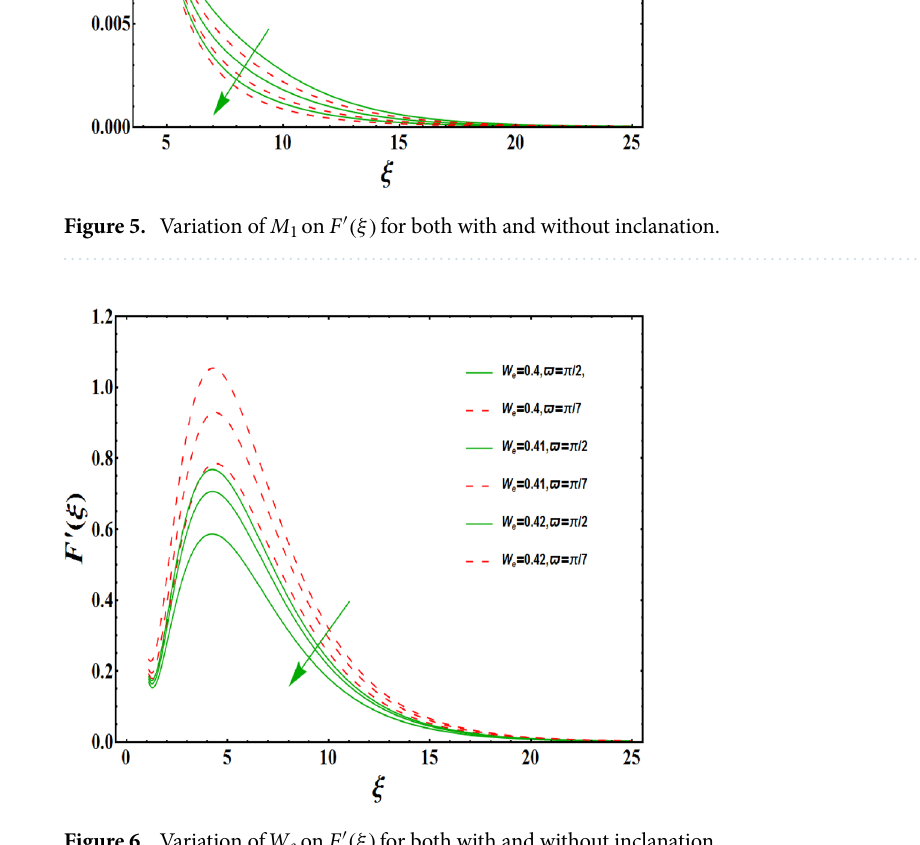
Figure 6. Variation of W e on F ′ (ξ) for both with and without